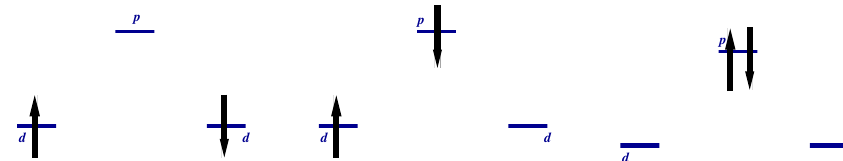
(cid:12) (cid:11) states (27)–(30) in a “Cu-O-Cu” (cid:12) s p